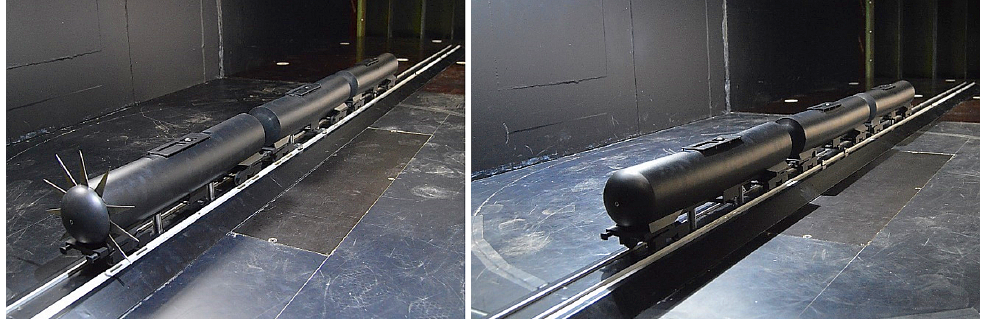
Figure 4. Model of tank wagon train in test section: ( Left ): leading wagon with spires, ( Right ): leading wagon without spires.